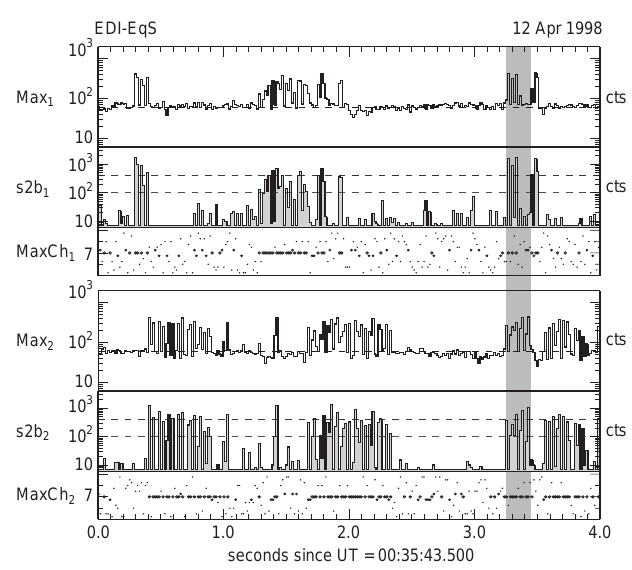
Fig. 4. Detector data for a 4-s period near apogee on 12 April when the magnetic field was 48 nT. The top three panels are for Detector 1: Max 1 shows the maximum counts (per 2 ms) recorded by any of the 15 correlators in Detector 1, and MaxCh 1 the correlator channel that received the maximum counts. The quantity s2b 1 is the square of the signal-to-noise ratio (SNR) computed from the counts in the correlators. If s2b 1 exceeds the threshold indicated by the lower dashed line , the on-board software assumes that the beam from Gun 2 has been detected by Detector 1; MaxCh 1 then indicates the correlator whose delay matches the time-of-flight of the beam electrons; when MaxCh 1 = 7, time-track has been achieved. (If s2b 1 exceeds the upper dashed line , this is used internally as a measure of the highest signal quality). The next three panels repeat the same information for Detector 2. The shaded area highlights the time interval discussed